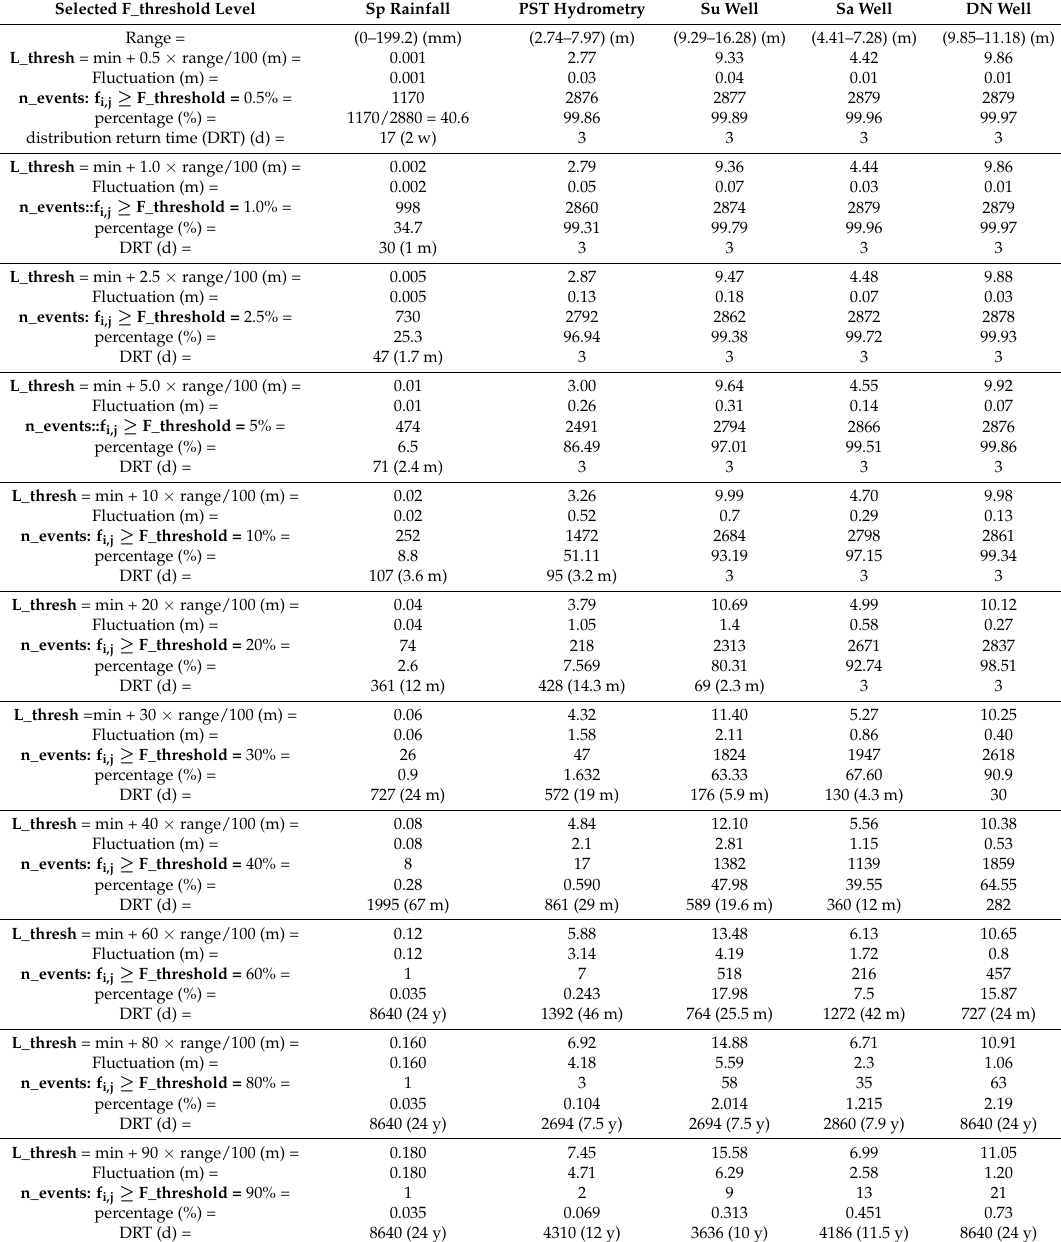
Table 3. Details of the Fractal analysis; d: days, w: week, m: months, y: years, F_threshold: the actual level (m) corresponding to the selected F_threshold f i , j ( % ) level (percentage of the whole variability